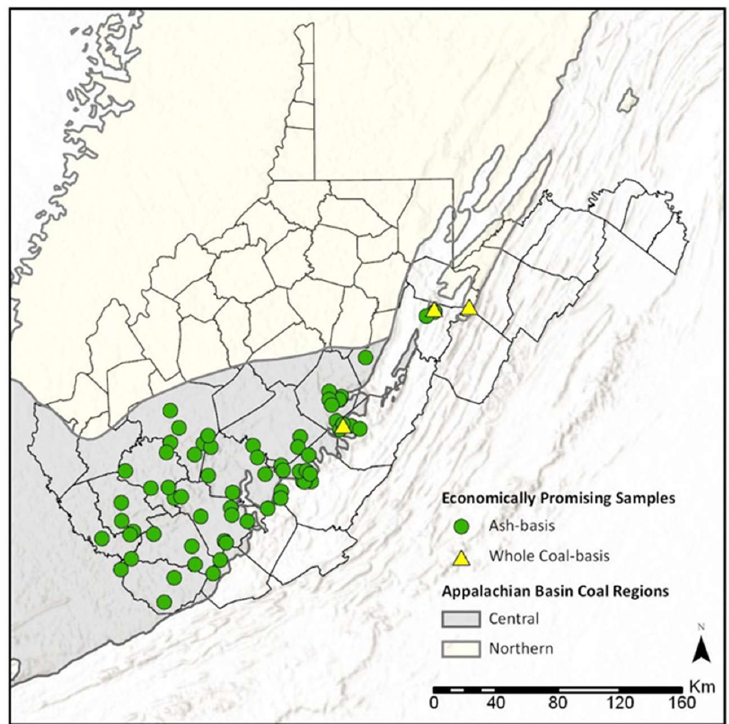
Figure 10. Locations of economically promising samples.